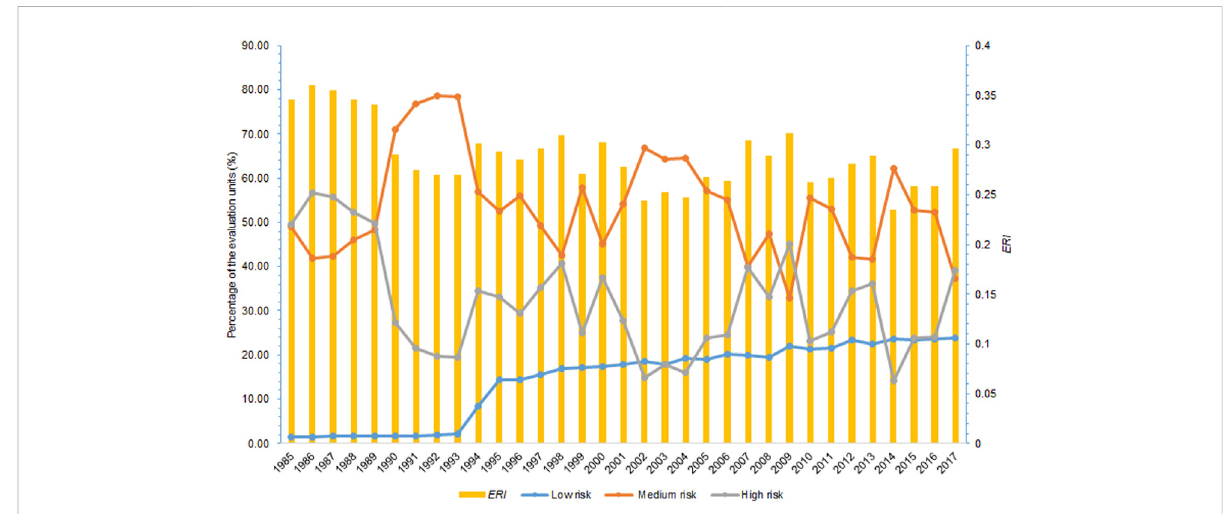
FIGURE 7 Interannual changes in ERI and percentage of assessment units with different ecological risk